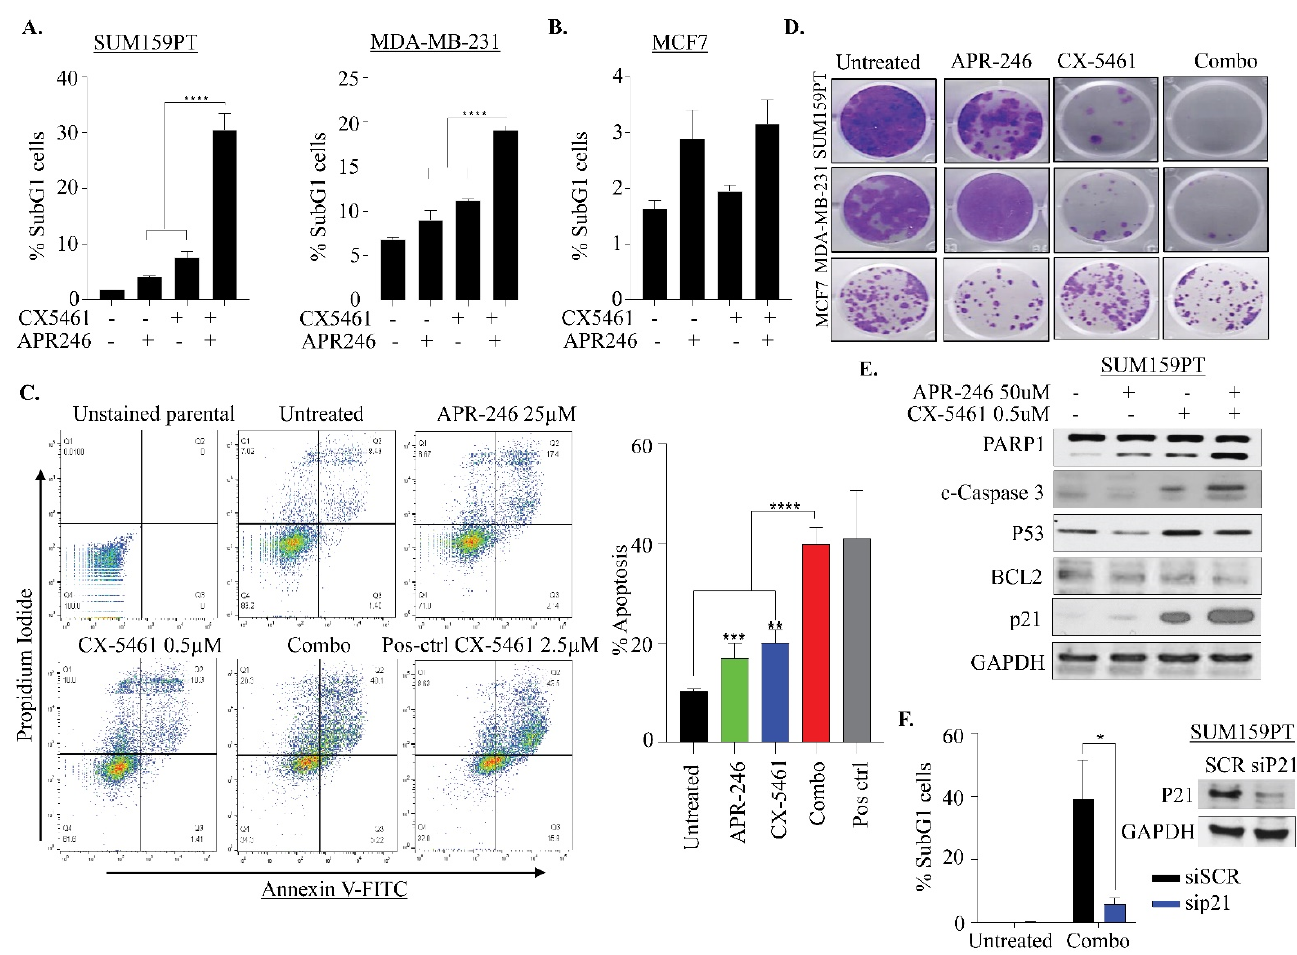
Figure 4. Impact of CX-5461 and APR-246 treatment on clonogenic survival and apoptosis. ( A,B ) Apoptotic fraction of sub-G1 population in SUM159PT, MDA-MB-231 and MCF7 determined by propidium iodide staining of cells treated with CX-5461 (0.5 µM) and APR-246 (25 µM) alone or in combination as described in of Figure 3. Graph represents the mean ± SD of two independent experiments. *** p ≤ 0.001. ( C ) Representative analysis images of SUM159PT cells treated with APR-246 (25 µM), CX-5461 (0.5 µM) alone and in combination for 48 h showing Annexin V/PI analysis. The top right quadrant represents the late apoptotic cells, while the bottom right quadrant the early apoptotic cells. Right: individual bar graph defines the additive number of cells in the late and early apoptotic stages. Cells treated with CX-5461 at 2.5 µM were used as positive control. Statistical analysis was carried out with one-way ANOVA and Dunnett’s multiple comparisons test relative to untreated parental. Mean ± S.D. n = 2. ** p ≤ 0.01; *** p ≤ 0.001; **** p ≤ 0.0001. ( D ) Representative images of colony-forming capacity of SUM159PT, MDA-MB-231 and MCF7 at 14 days in cells treated with APR-246 (50 µM) and CX-5461 (0.5 µM) alone and in combination, determined using crystal violet staining assays ( n = 2). ( E ) Western blot analysis of expression of apoptotic pathway proteins. The SUM159PT cells treated with APR-246 (50 µM), CX-5461 (0.5 µM) alone and in combination for 24 h were analyzed for indicated protein expression. GAPDH was used as a loading control. ( F ) SUM159PT cells were reverse-transfected with 10 nM pooled p21 siRNAs for 48 h, followed by combination treatment with CX5461/APR-246 and apoptotic fraction of sub-G1 population was determined by propidium iodide staining, using flow cytometry. Mean ± S.D. n = 2. * p ≤ 0.05. Western blot image shows efficiency of P21 knockdown in SUM159PT cells.